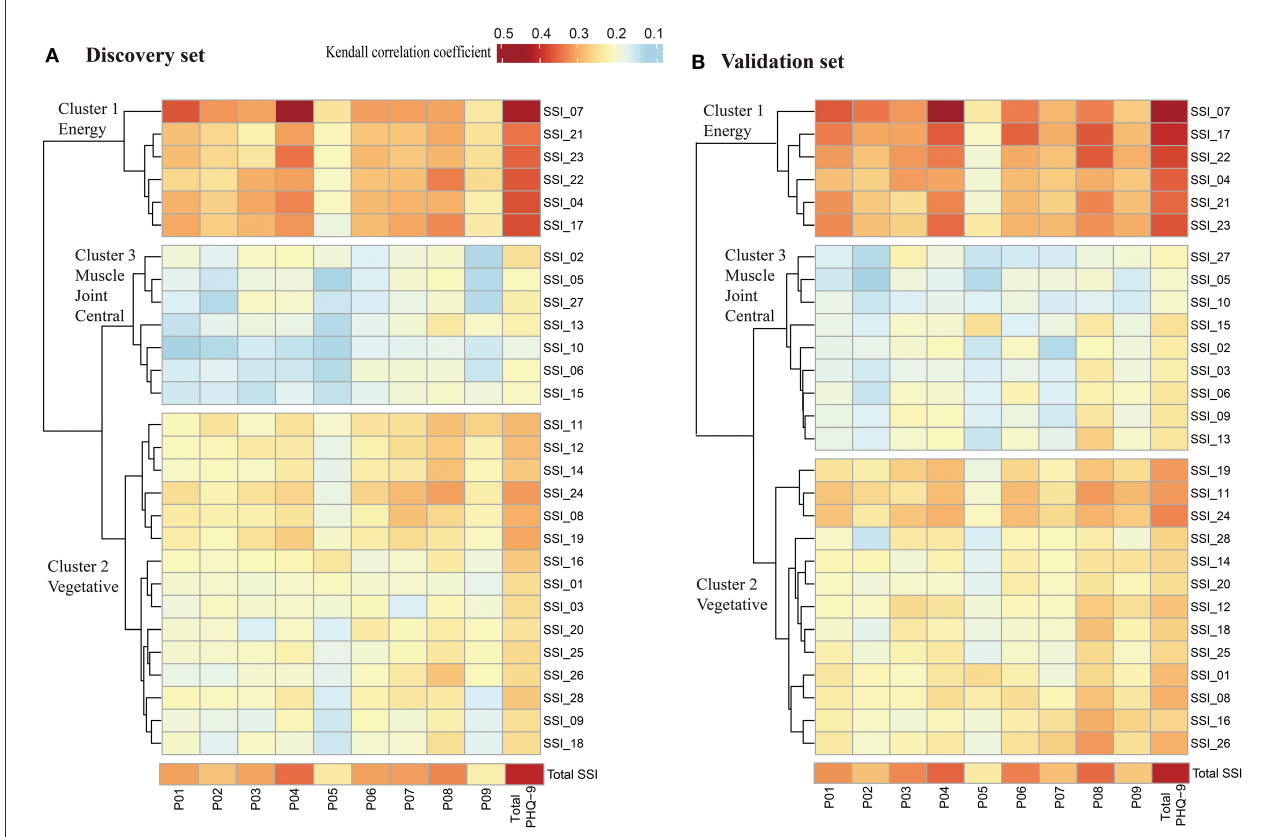
FIGURE1 Heatmap of Kendall correlation coefficient between SSI and PHQ-9. (A) Heatmap of Kendall correlation coefficient between SSI and PHQ-9 in discovery set ( n = 2,070); (B) Heatmap of Kendall correlation coefficient between SSI and PHQ-9 in validation set ( n = 2069). Significant correlations were found between each SSI item and each PHQ-9 item using Kendall correlation analysis ( P < 0.05). Hierarchical clustering analysis was applied to the yield clusters of the 28 SSI items based on their Kendall correlation coefficients with PHQ-9, and the number of clusters was decided based on the proportion of variation in the data captured by the clusters. PHQ-9, indicates patient health questionnaire-9; P01 to P09, represents item 1 to item 9 in PHQ-9; SSI indicates somatic symptoms inventory; SSI_01 to SSI_28, represents item 1 to item 28 in SSI. Cluster 1 consists of 6 energy-related symptoms, including fatigue, weakness, faintness or dizziness, heavy arms or legs, feeling unwell most of the time in the past few years, feeling not in as good physical health most friends; Cluster 2 consists of 15 vegetative symptoms, including nausea and vomiting, pains, or cramps in abdomen, indigestion, upset stomach, or acid stomach, fullness in head or nose, back pain, trouble in catching, breath, pains in heart or chest, heart pounding, turning over or missing a beat, numbness, tingling or burning, headaches, lump in throat, hands and feet not feeling warm enough, sense that hearing is not as good as it used to be; Cluster 3 consists of 7 muscle, joint and central nervous symptoms, including muscles soreness, muscles twitching or jumping, joint pain, trouble with vision, ringing, or buzzing in ears, difficulty in keeping balance while walking, constipation.